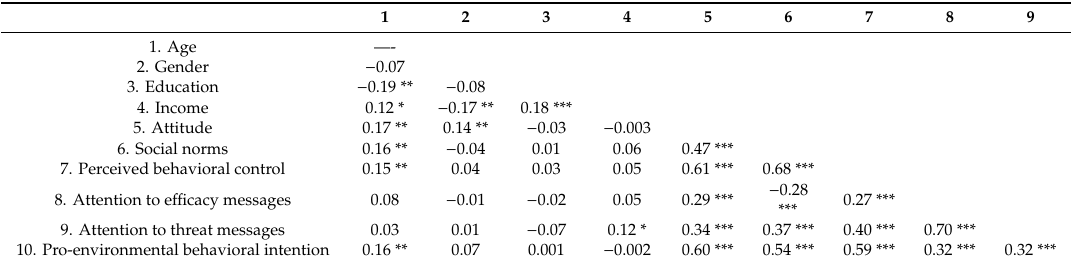
Figure 2. Pro-environmental behavior intention by attitude and attention to efficacy messages. Table 1. Bivariate correlation of all